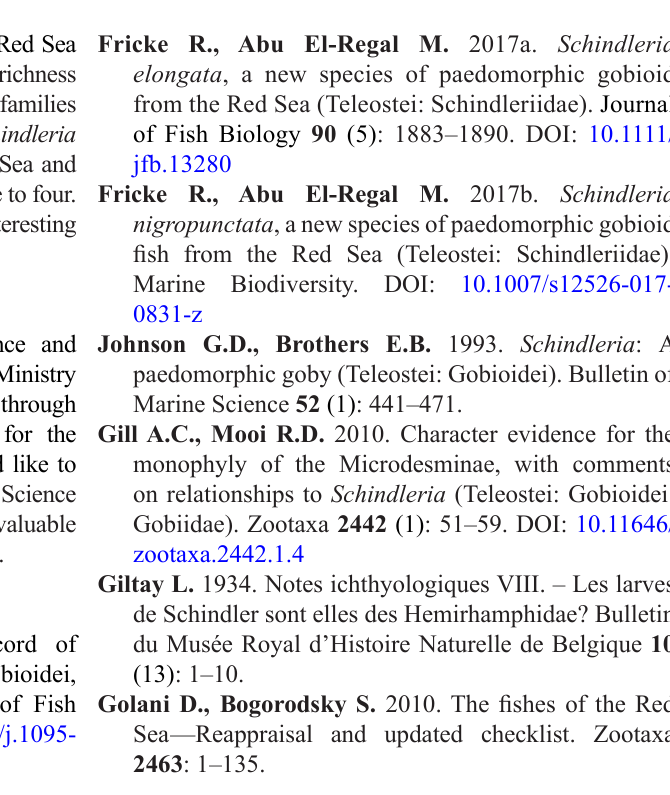
Fig. 2. Distribution of species in the genus Schindleria in the Indo-Pacific (After Fricke and Abu El-Regal 2017b.); 1 = Schindleria elongata and S. nigropunctata ; 2 = Schindleria pietschmanni ; 3 = Schindleria praematura ; 4 = Schindleria brevipinguis ; 5 = Schindleria spp. (not assigned to any nominal